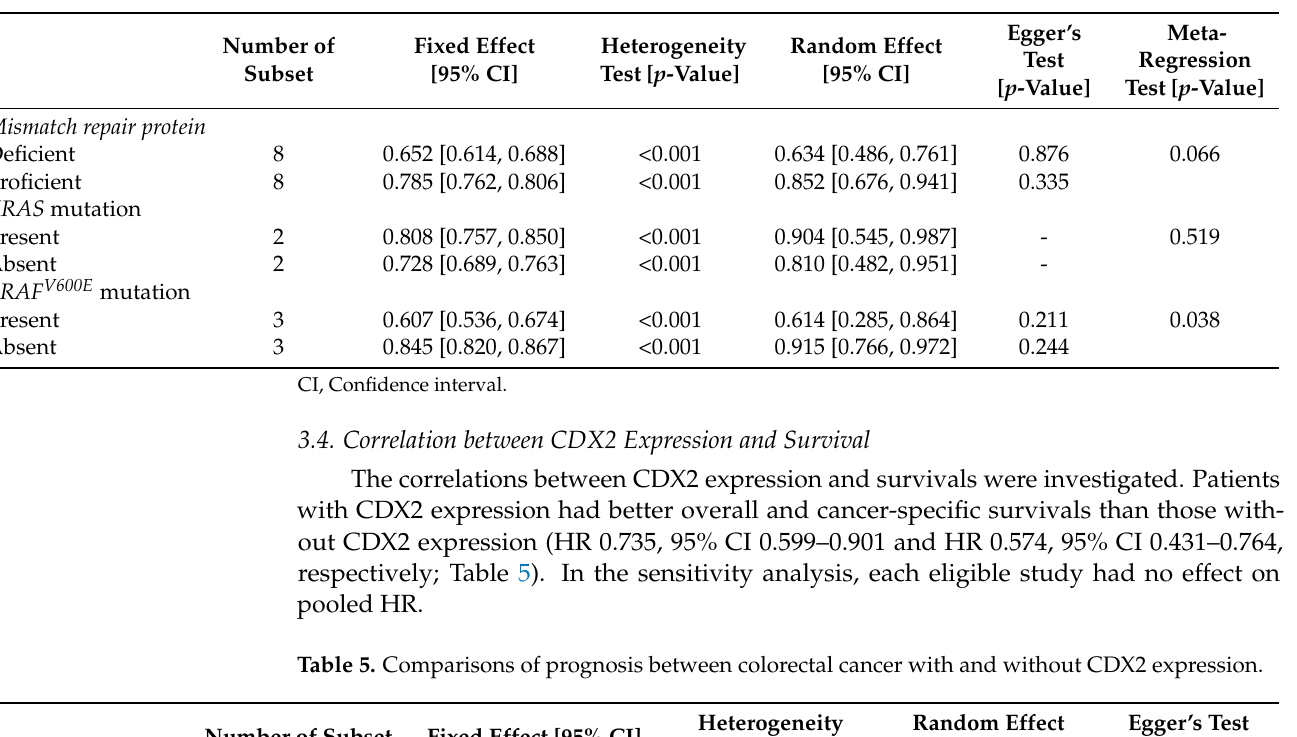
Table 4. Comparisons of genetic mutation between colorectal cancer with and without CDX2 expression.